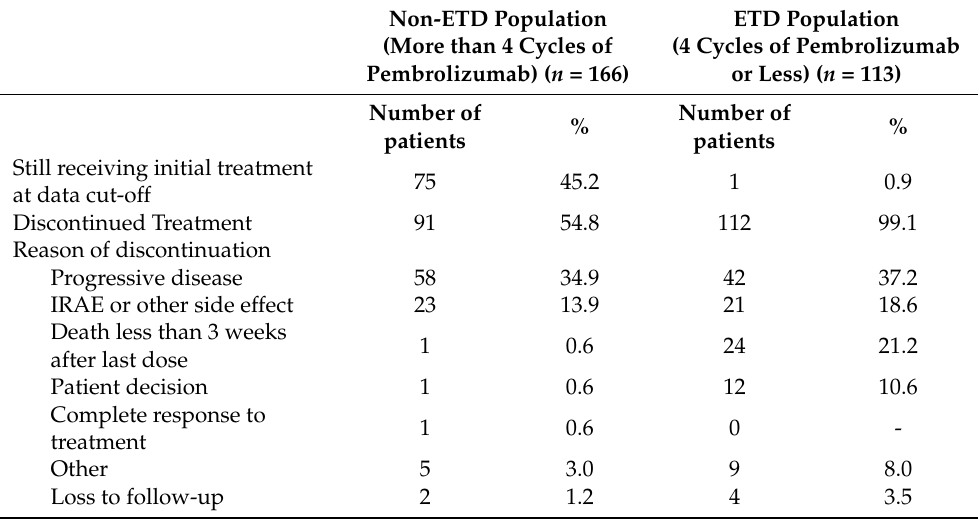
Table 4. Reasons for discontinuing pembrolizumab treatment.